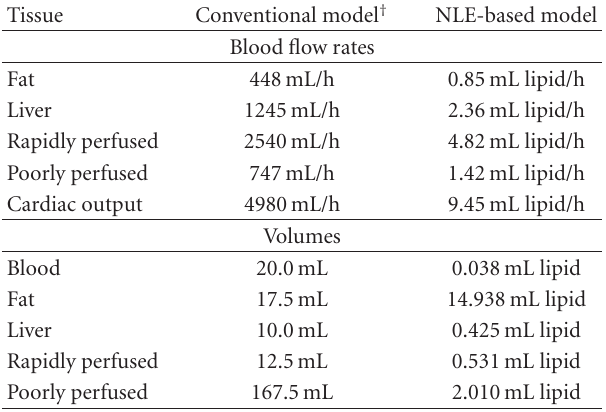
Table 2: Physiological values for a standard 225 g rat (adapted from